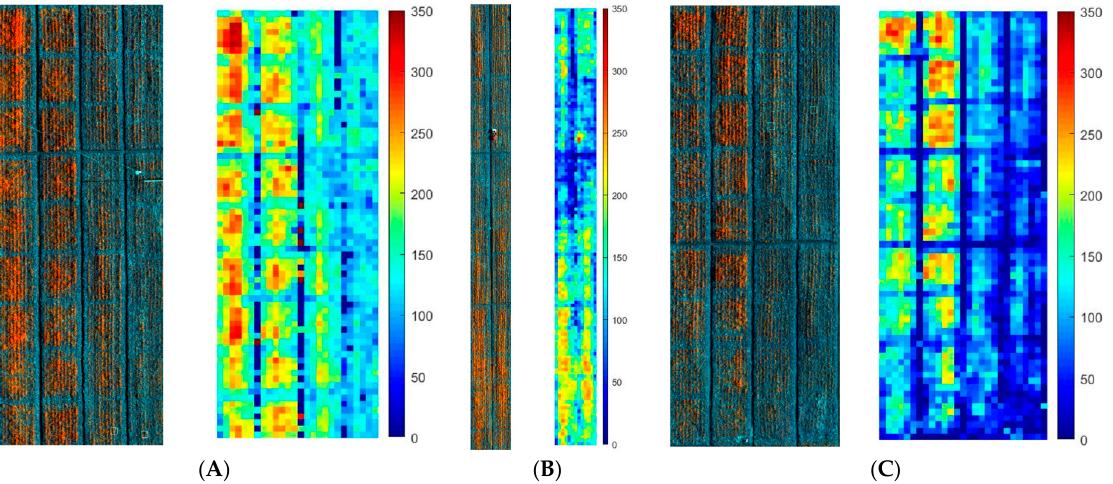
Figure 15. Models optimized by gradient characteristics were used to estimate winter wheat tiller numbers in the whole field. ( A ) Variety 1, ( B ) variety 2, and ( C ) variety 3.